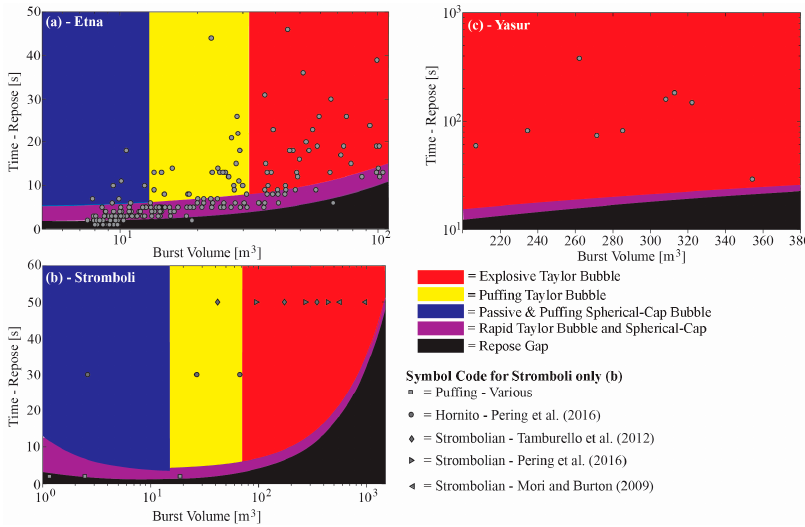
Figure 3. Outputs from the model run with input conduit and fluid dynamic parameters appropriate to: ( a ) Mt. Etna; ( b ) Stromboli; and ( c ) and Yasur volcanoes. Overlain on the plots are data points derived from field measurements on these targets, for Etna from Pering et al. [24], and Yasur from Kremers et al. [33]. In the Stromboli case, a number of literature sources are referred to, as detailed above. In each case a single repose interval is applied, which is a minimum for the observed activity. Figure 3b also just shows the maximum, mean, and minimum burst volumes from each of the Stromboli papers to simplify the graphic.